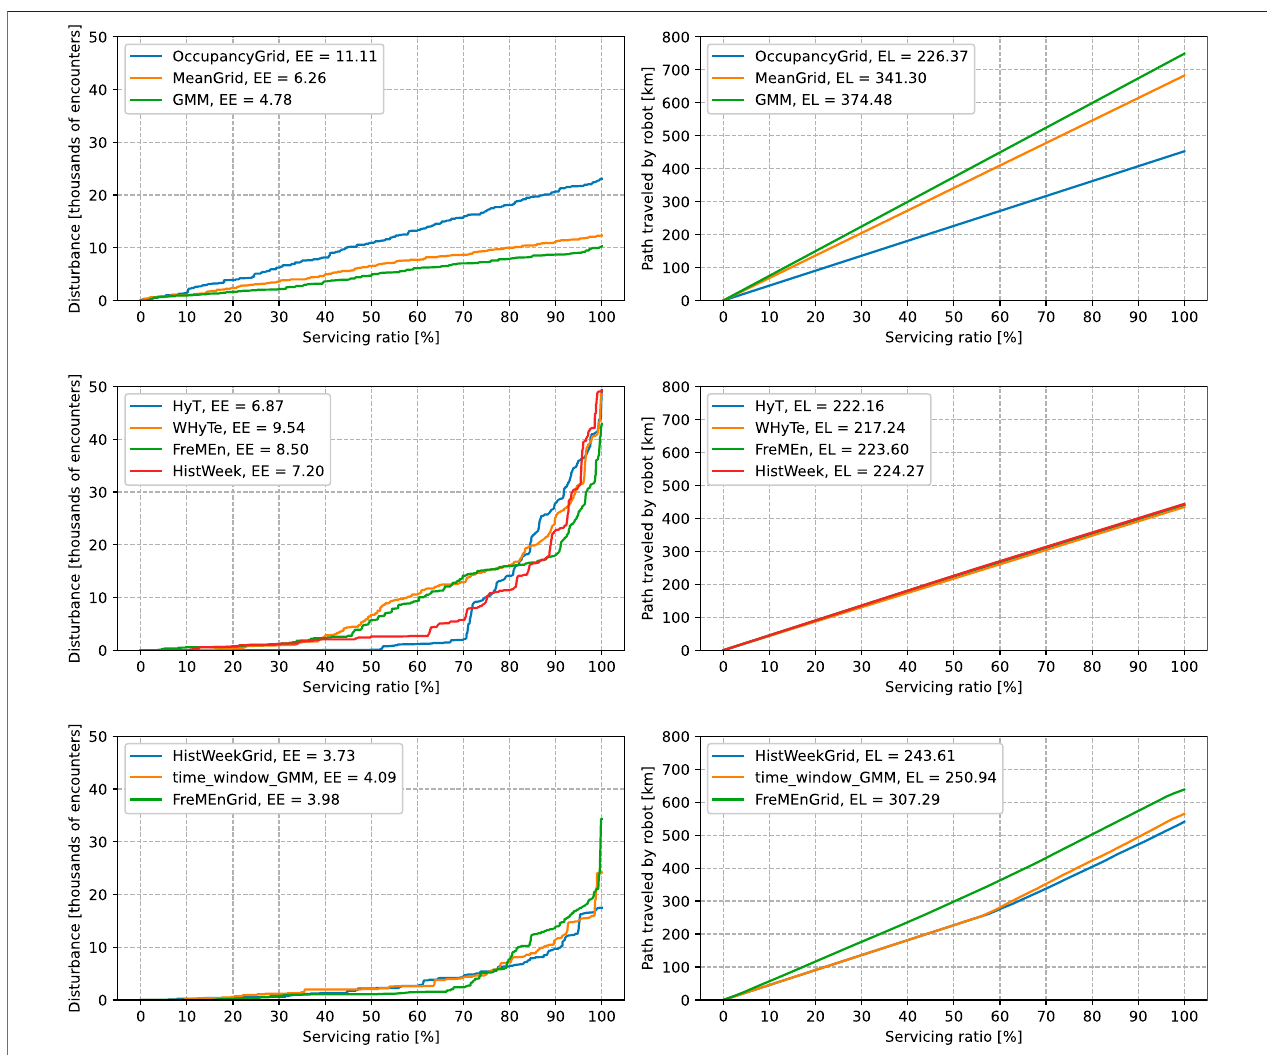
FIGURE 5 | Comparison of different models in the spatio-temporal scenario. The left columns of graphs depict service disturbances, the quantile functions of the ordered human – robot encounters. The right columns of graphs depict traveled distances, the quantile functions of lengths of paths. The labels in graphs consist of names of models and the expected